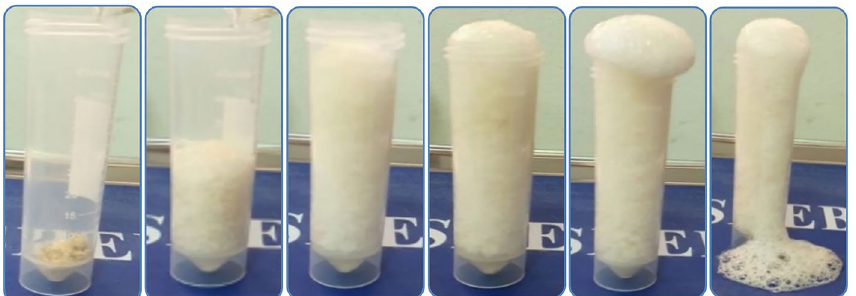
Figure 8. Eruption and CO 2 release after adding 2 M of HCl to the precipitate which indicates the formation of